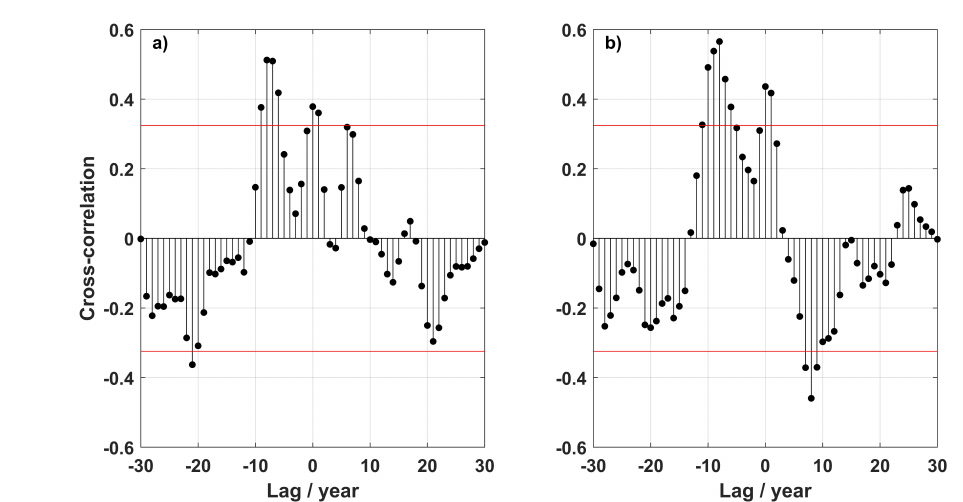
Figure 3. ( a ) Cross-correlation between the North Atlantic Oscillation and the CTD/Argo tempera- ture detrended anomaly time-series, and the EN4 temperature anomaly time-series ( b ). The cross- correlation was calculated using 3-years running mean of both NAO-winter index and the an- nual mean temperature anomaly time-series. Red lines represent the upper and lower 95% confi- dence